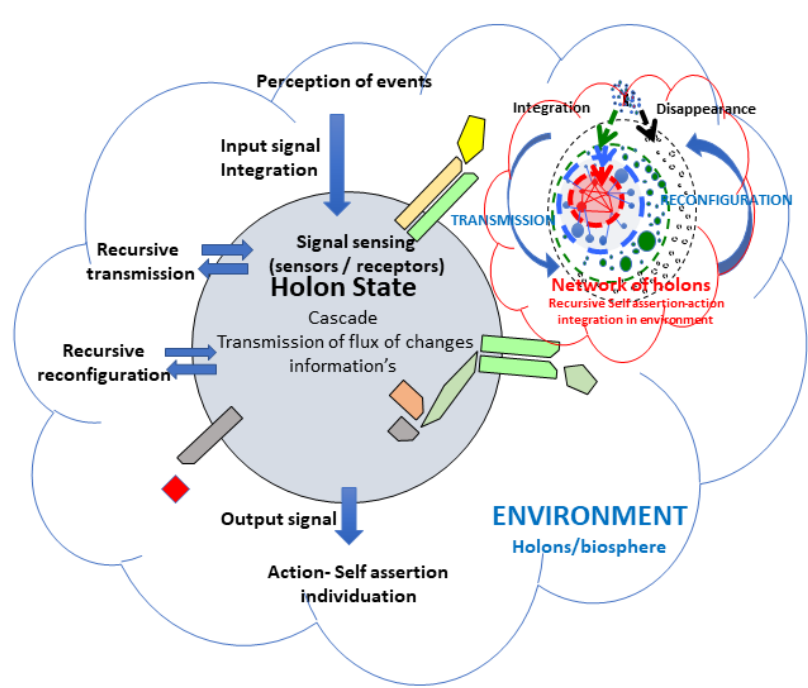
Figure 1: Abstraction of biological communicating living holons, as dynamical systems perceiving fluxes of events, detecting signals and reacting in self-similar networks. As an example (adapted from [3]), a cell is the smallest au- tonomous living dynamical system that can be modeled as a perceptive / reactive degenerate holon capable of perception, recursive transmission and reconfiguration of its state and functions. A cell is a local observer equipped with a network of thousands of internal and external holon-molecules that can combine together to make the cell integrate internal and external fluxes of changes. Holons can communicate by integrating input signals, transmitting flux of changes and gener- ating output signals and